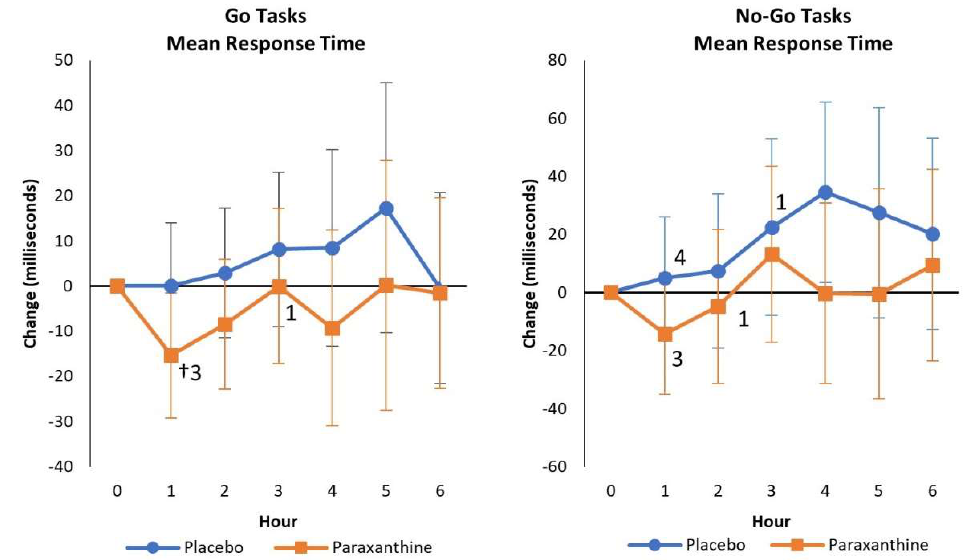
Figure 4. Mean changes with 95% confidence interval data from baseline in Go and No-Go mean response times. † represents p < 0.05 change from baseline values. Numbers 1, 2, 3, 4, 5, and 6 represent p < 0.05 differences from the hour values shown.